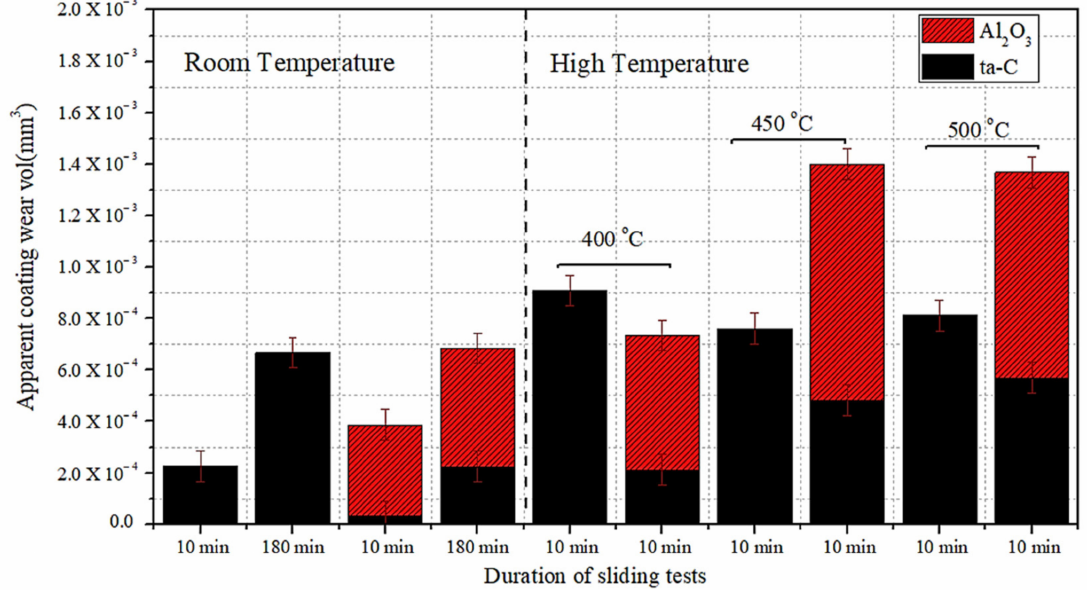
Figure 6. Apparent wear volumes on the ta-C (black) and Al 2 O 3 /ta-C (black + red) coatings. Raman spectroscopy is a standard technique to reveal the nature of carbon–carbon bonding [27–29]. Raman measurements were repeated for at least three different locations within the wear scar. The results obtained on the pristine and wear scar surfaces of the ta-C and Al 2 O 3 /ta-C coatings are shown in Figures 7 and 8. The D and G band peaks position and intensity and full width at half maximum of the G peak (FWHM(G)) were obtained using Gaussian functions fitting of Raman spectra. The G peak is assigned to the stretching of sp 2 bonds on both ring and chains, whereas the D peak is assigned to the